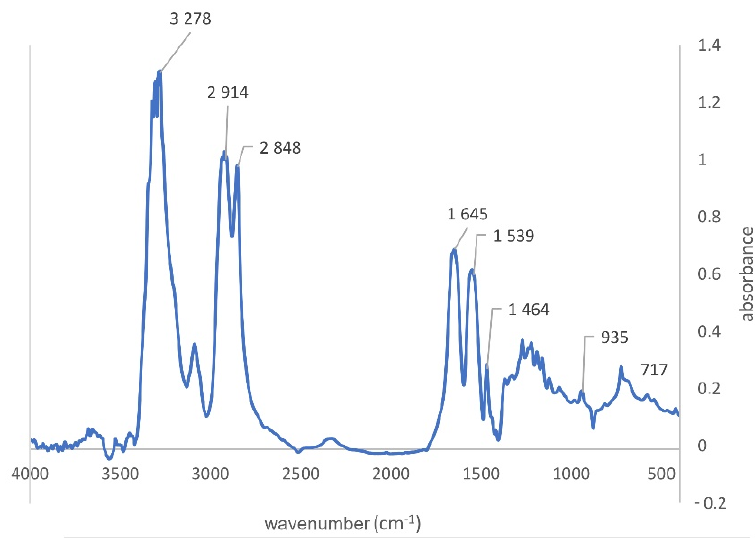
Figure 3. Infrared spectra of PA12 sample.